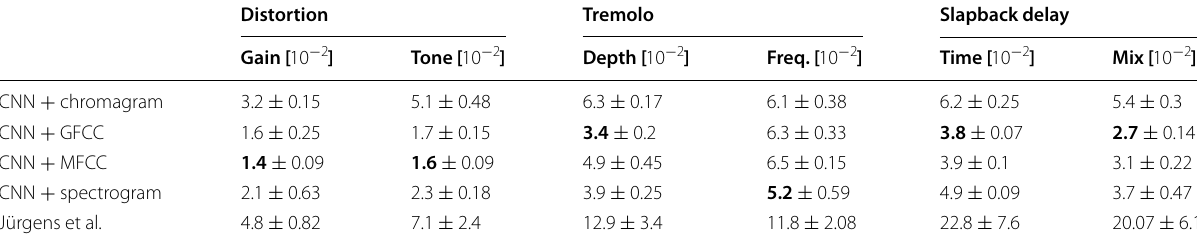
Table 4 95% confidence interval of the mean absolute error of the CNN across the fivefold cross-validation of the parameter extraction and all volumes for the individual effects. Results are given for Jürgens et al. [12] as well. The lowest errors are highlighted using bold font